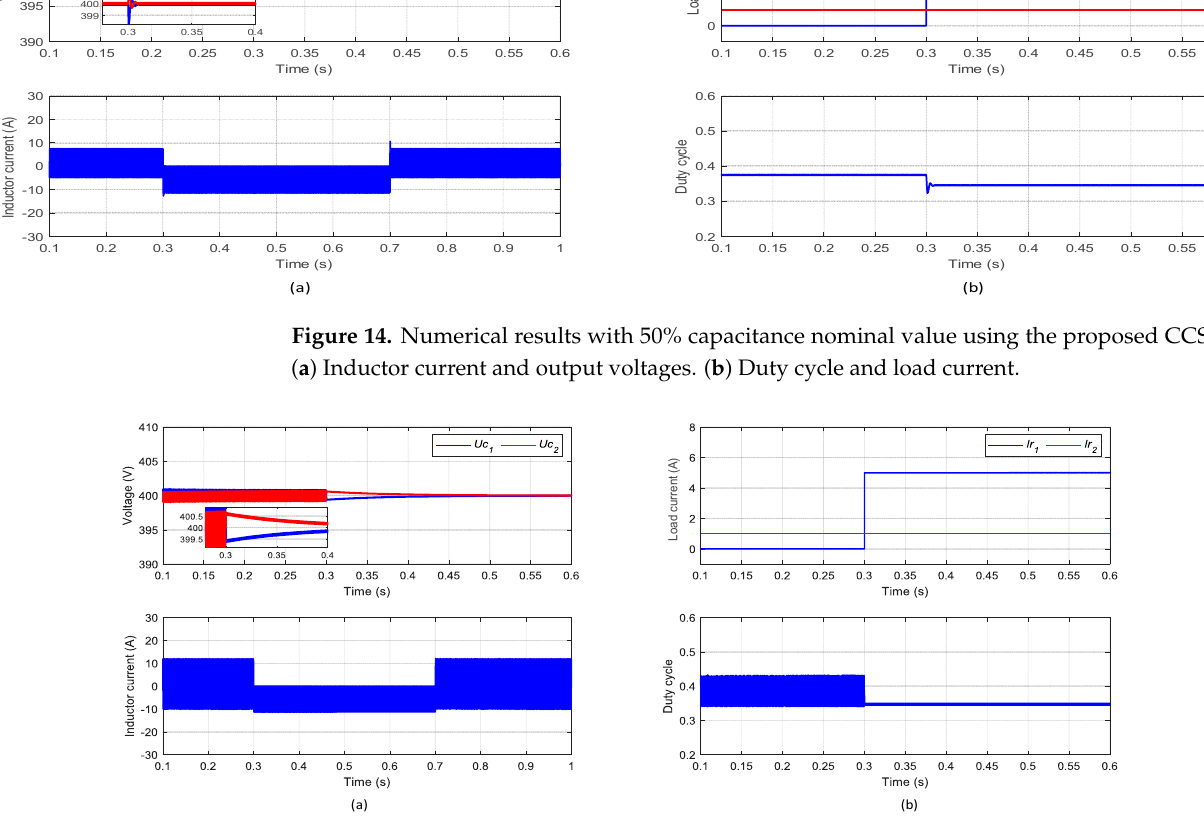
Figure 15. Numerical results with 50% capacitance nominal value using the GA – PI controller. ( a ) Inductor current and output voltages. ( b ) Duty cycle and load current.